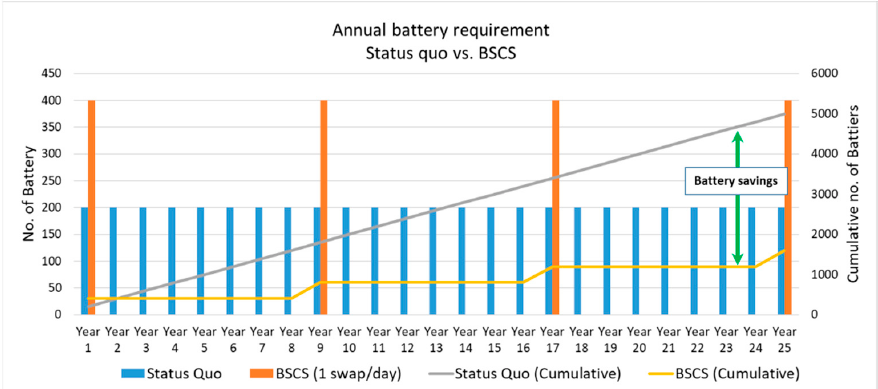
Figure 18. Annual battery requirements for 50 e-rickshaws. The blue bars represent status quo, which is no swapping and no battery management and considering 1-year lifetime. Orange bar represents battery requirements for BSCS with one swap a day with battery management to maintain 60% DOD. Battery lifetime was set to be 8 years considering one cycle in two days.